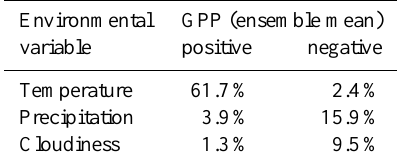
Table 6. Connection between annual GPP of northern Eurasia (GPPsat) and summer values of environmental variables shown as percentage of the study area with statistically significant (95% sig- nificance level) positive and negative partial correlation